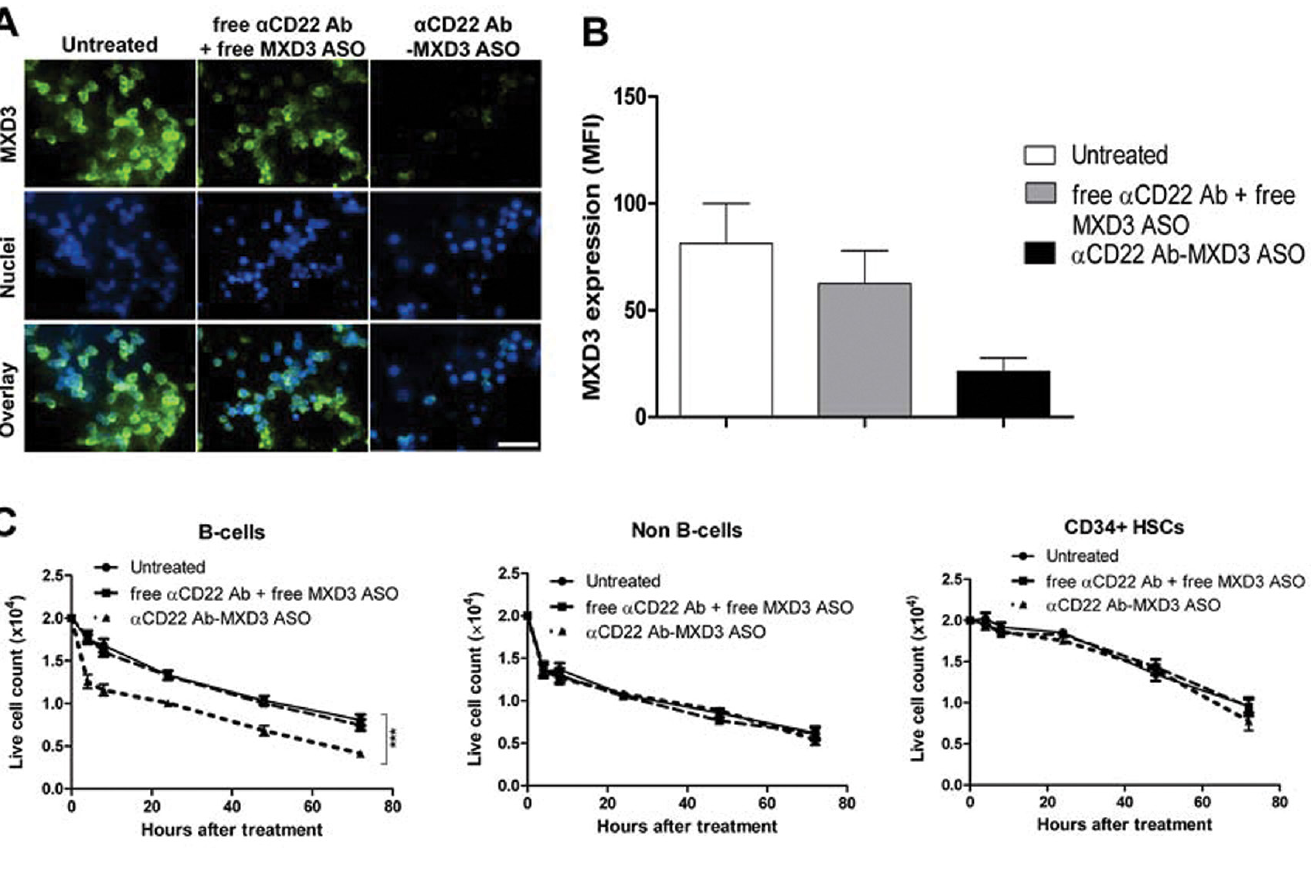
Figure 2. α CD22 Ab-MXD3 ASO conjugate has cytotoxicity in normal B cells, but not in HSCs. (A) Normal B cells express low levels of MXD3 and treatment with the α CD22 Ab-MXD3 ASO conjugate showed knockdown. Images were acquired at 40× magnification/1.4 numerical aperture at room temperature using a Nikon Ti-U inverted microscope and NIS-Elements BR software. Scale bar indicates 50 μ m. Free α CD22 Ab (azide-conjugated) + free MXD3 ASO also showed low levels of non-specific knockdown. The images shown are from one representative experiment out of three experiments. (B) MXD3 protein knockdown quantified using MFI. Each bar represents the average MFI of all mea- sured cells per treatment type from three independent experiments. (C) Accelerated cell death in B cells treated with the α CD22 Ab-MXD3 ASO conjugate. Data points indicate mean values of independent cell counts in triplicate from three independent experiments in triplicate. Data as mean ± SEM (n = 9). The MXD3 α CD22 Ab-ASO conjugate versus free α CD22 Ab (azide-conjugated) + free MXD3 ASO (*** p < models. A summary of known clinical, phenotypic, and molecular character- istics are included in Supplementary